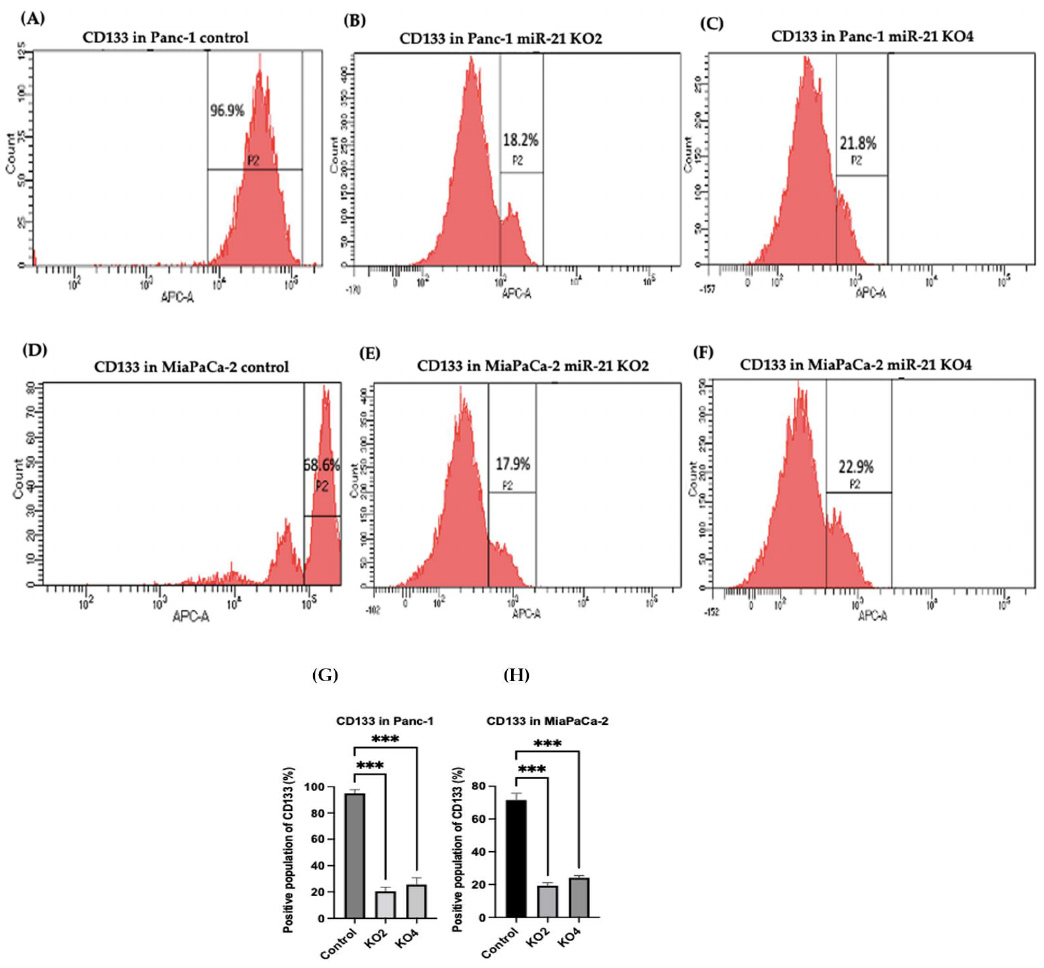
Figure 5. Flow cytometry analysis of CD133 in PDAC control and miR-21 KO cell lines. ( A – C ): Expression of CD133 in the Panc-1 miR-21 Kos and control: ( A ) Panc-1 vector alone (control cells); ( B ) miR-21 KO2; ( C ) miR-21 KO4. ( D – F ): Expression of CD133 in MiaPaCa-2 miR-21 Kos. ( D ) MiaPaCa- 2 vector alone (control cells); € miR-21 KO2; ( F ) miR-21 KO4. ( G ) Percentage of the CD133 positive population in Panc-1 cells and their miR-21 KOs. CD133 expression was significantly increased in the Panc-1 vector alone compared with the miR-21 KOs in the Panc-1 cell line. The column graphic represents the average of three replicates of RNA isolated from Panc-1 control cells and their KOs. Data normalized according to RPII expression by fold analysis ( n = 3, p < 0.05). ( H ) Percentage of the CD133 positive population in MiaPaCa-2 cells and their miR-21 KOs. CD133 expression was signif- icantly increased in MiaPaCa-2 control cells compared with their miR-21 KOs. The column graphic represents the average of three replicates of RNA isolated from MiaPaCa-2 control cells and their KOs. Data normalized according to RPII expression by fold analysis ( n = 3, p < 0.05). Numbers in the